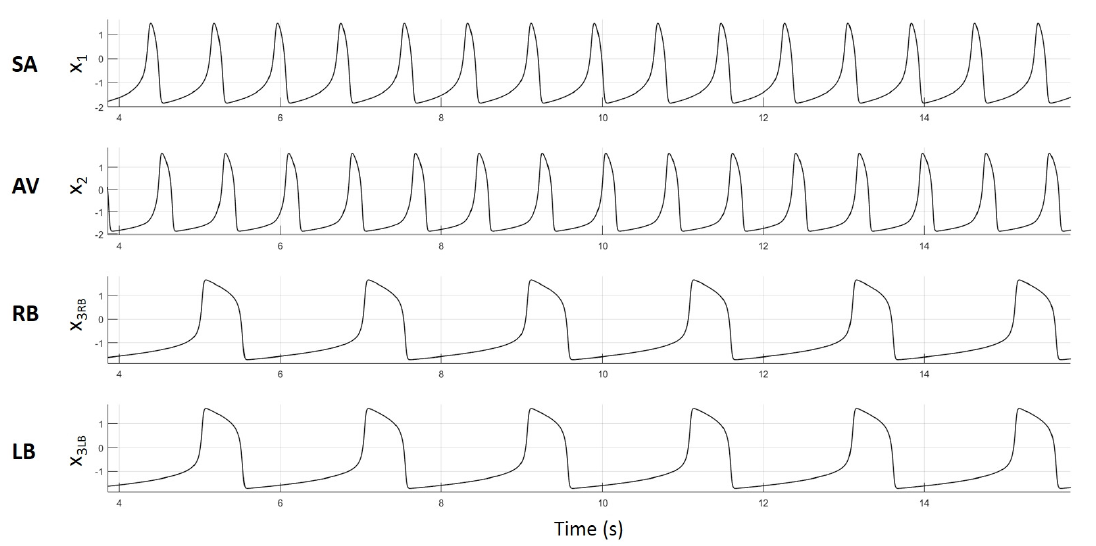
Figure 3. Action potentials of uncoupled oscillators. Intrinsic oscillation rates of 70 bpm, 50 bpm, 35 bpm and 35 bpm for uncoupled SA , AV , RB and LB ,